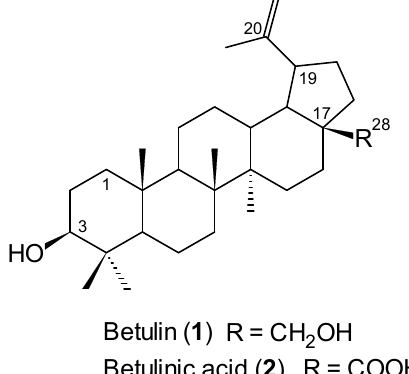
Figure 1. Structure of betulin ( 1 ) and betulinic acid ( 2 ).